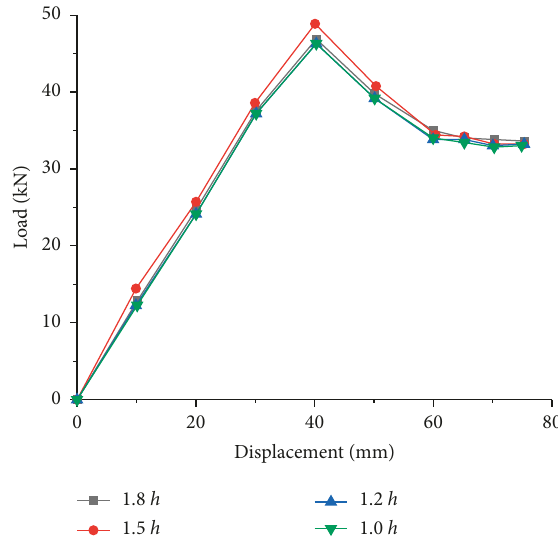
Figure 20: Load-displacement curves of joints with different sleeve heights.